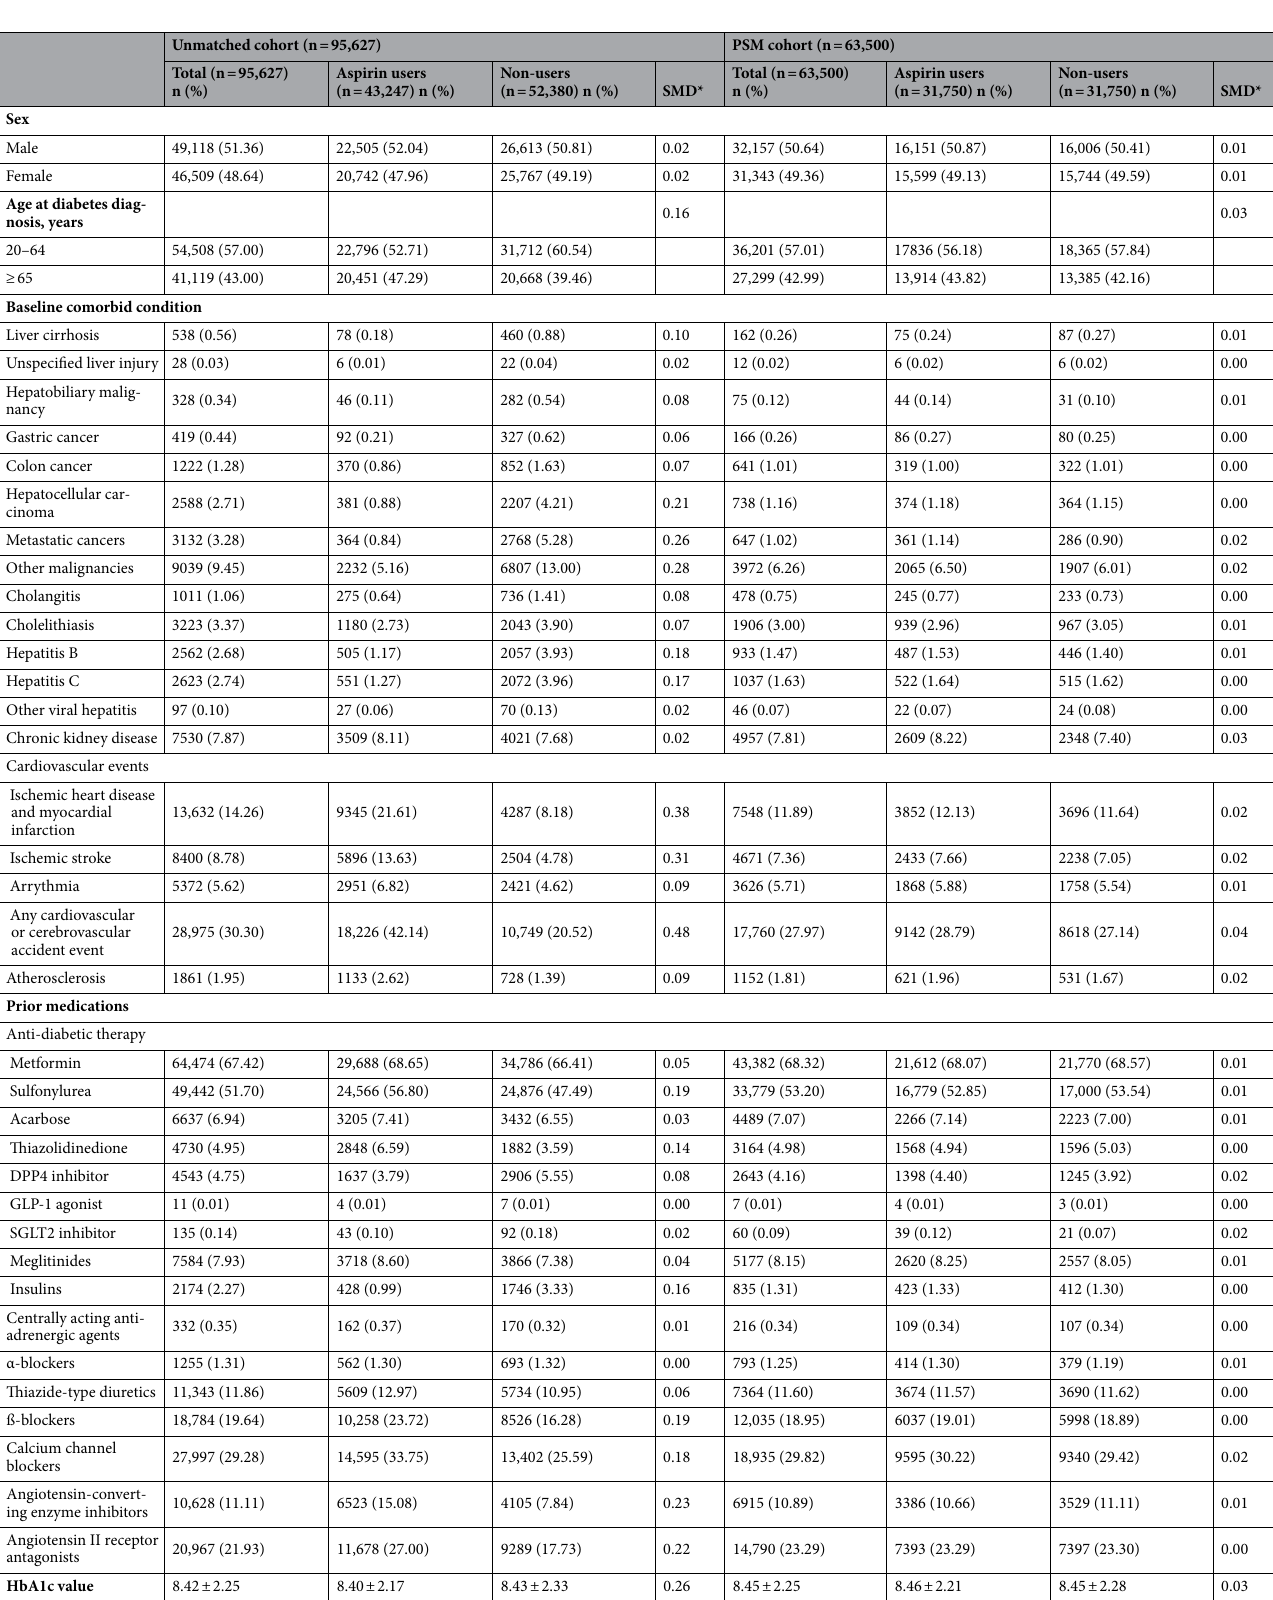
Table 1. Baseline characteristics before and after propensity score matching. DPP4, dipeptidyl peptidase 4 inhibitors; GLP1, glucagon-like peptide-1 analogues; HbA1c, glycated hemoglobin; SGLT2,